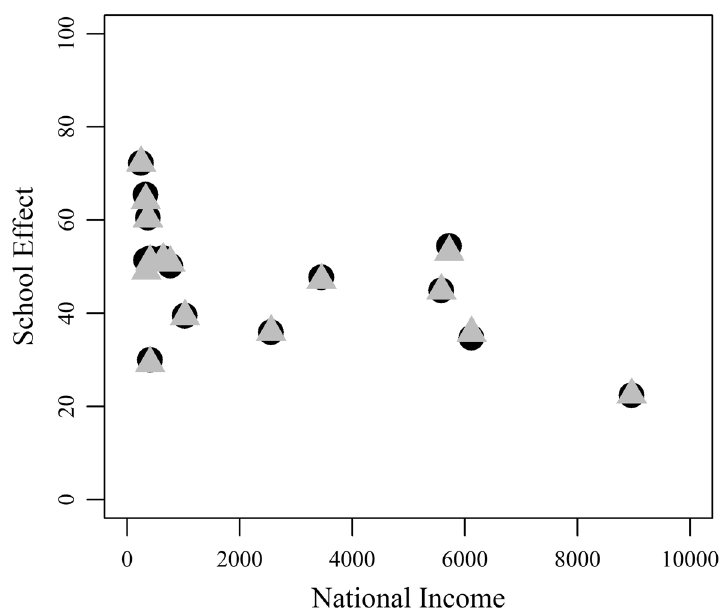
Fig. 7 National income and the school effect for HIV/AIDS Knowledge. Note. Black points and gray triangles are the naive and correction parameter estimates for the school effect. Both school effects are posterior